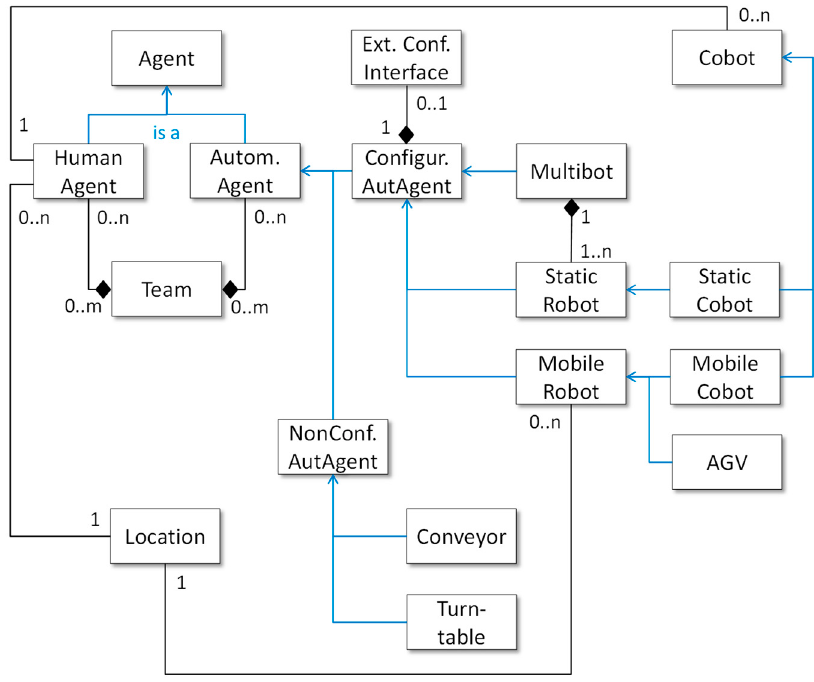
Figure 12. HORSE agent concept model [27].